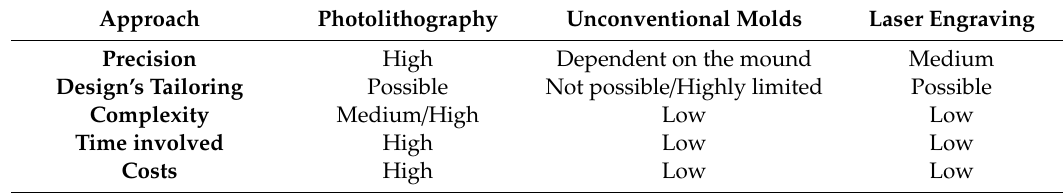
Table 3. Comparison of the two widely used approaches for the micro-structuring of films, photolithography and unconventional molds, and the emerging laser engraving technique. Approach Photolithography Unconventional Molds Laser Engraving Precision High Dependent on the mound Medium Design’s Tailoring Possible Not possible / Highly limited Possible Complexity Medium /